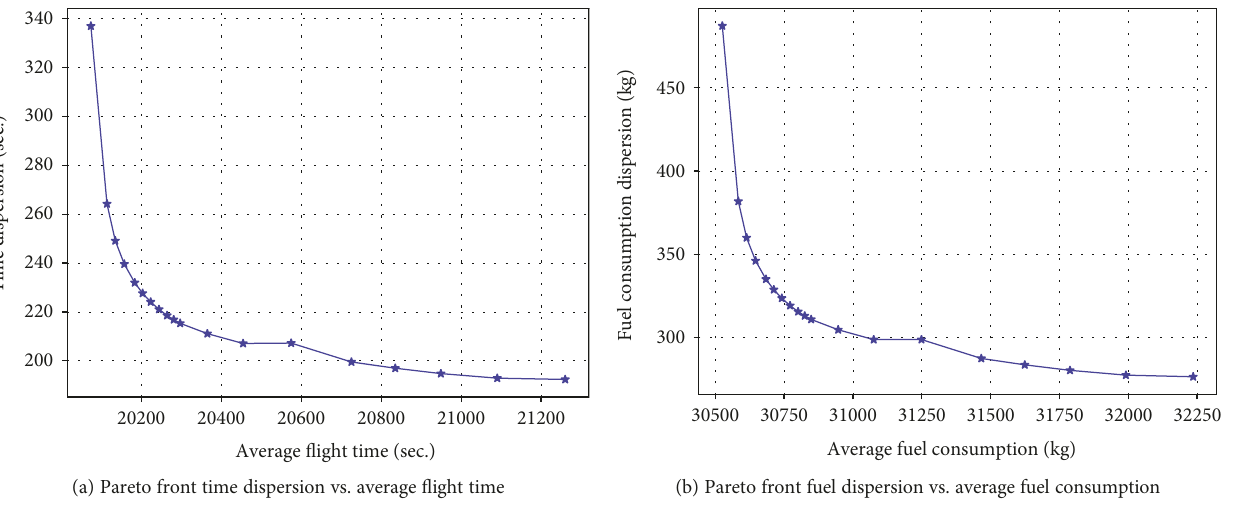
Figure 8: 2016-Oct-05: trade-o ff solutions of the